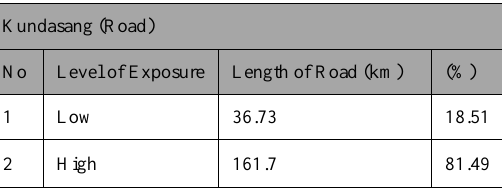
Table 4: Level of road exposure toward hazard in